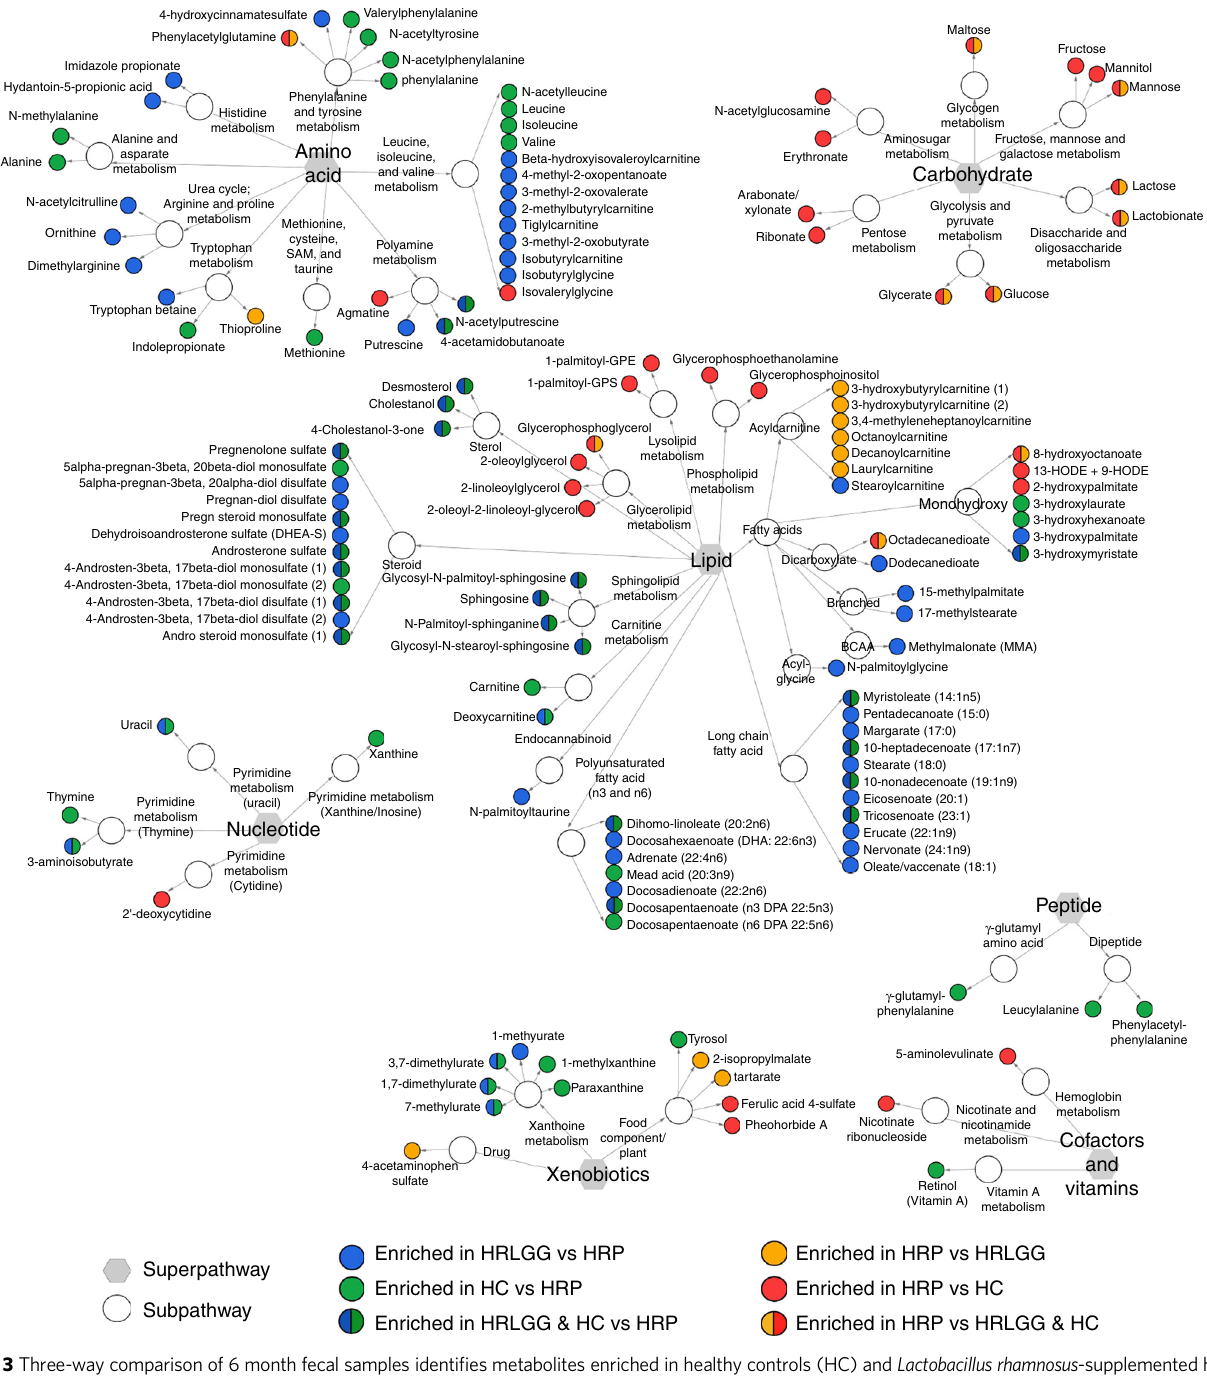
Fig. 3 Three-way comparison of 6 month fecal samples identi fi es metabolites enriched in healthy controls (HC) and Lactobacillus rhamnosus -supplemented high risk for asthma (HRLGG) subjects compared to high risk for asthma placebo (HRP) group. HC ( n = 15) and HRLGG ( n = 7) participants share a number of common enriched metabolites compared with HRP ( n = 11) group, including anti-in fl ammatory androgenic steroids, long-chain and polyunsaturated fatty acids. In comparison HRP subjects exhibit evidence of increased glycolysis and for distinct products of lipid metabolism (Welch ’ s two-sample t -test; p ≤